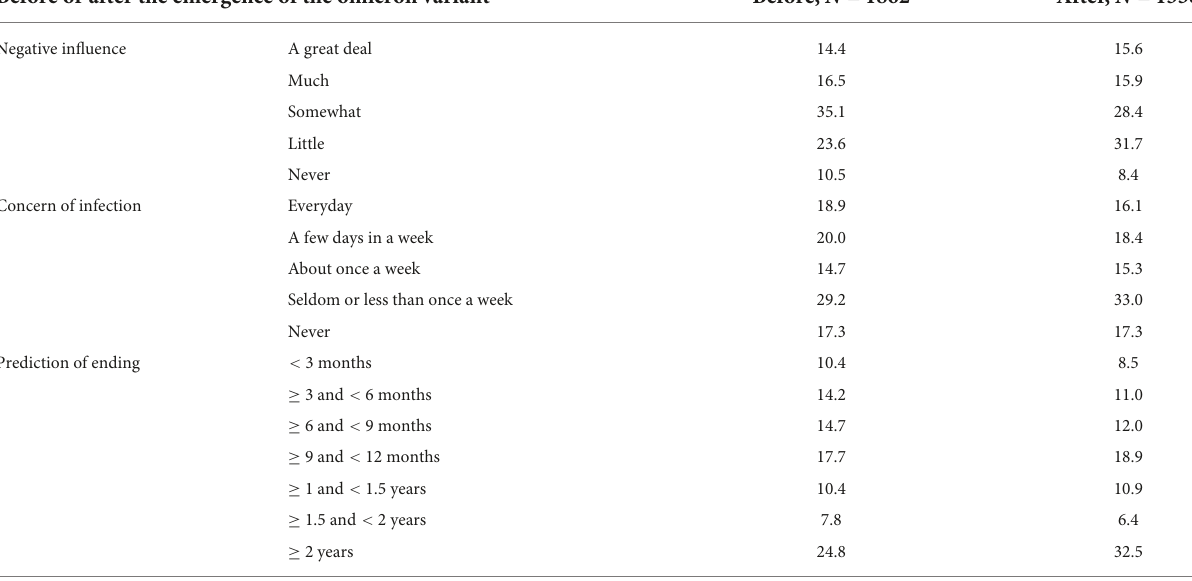
TABLE 2 The weighted distributions (%) of three perception outcomes, before and after the emergence of the omicron variant. Before or after the emergence of the omicron variant